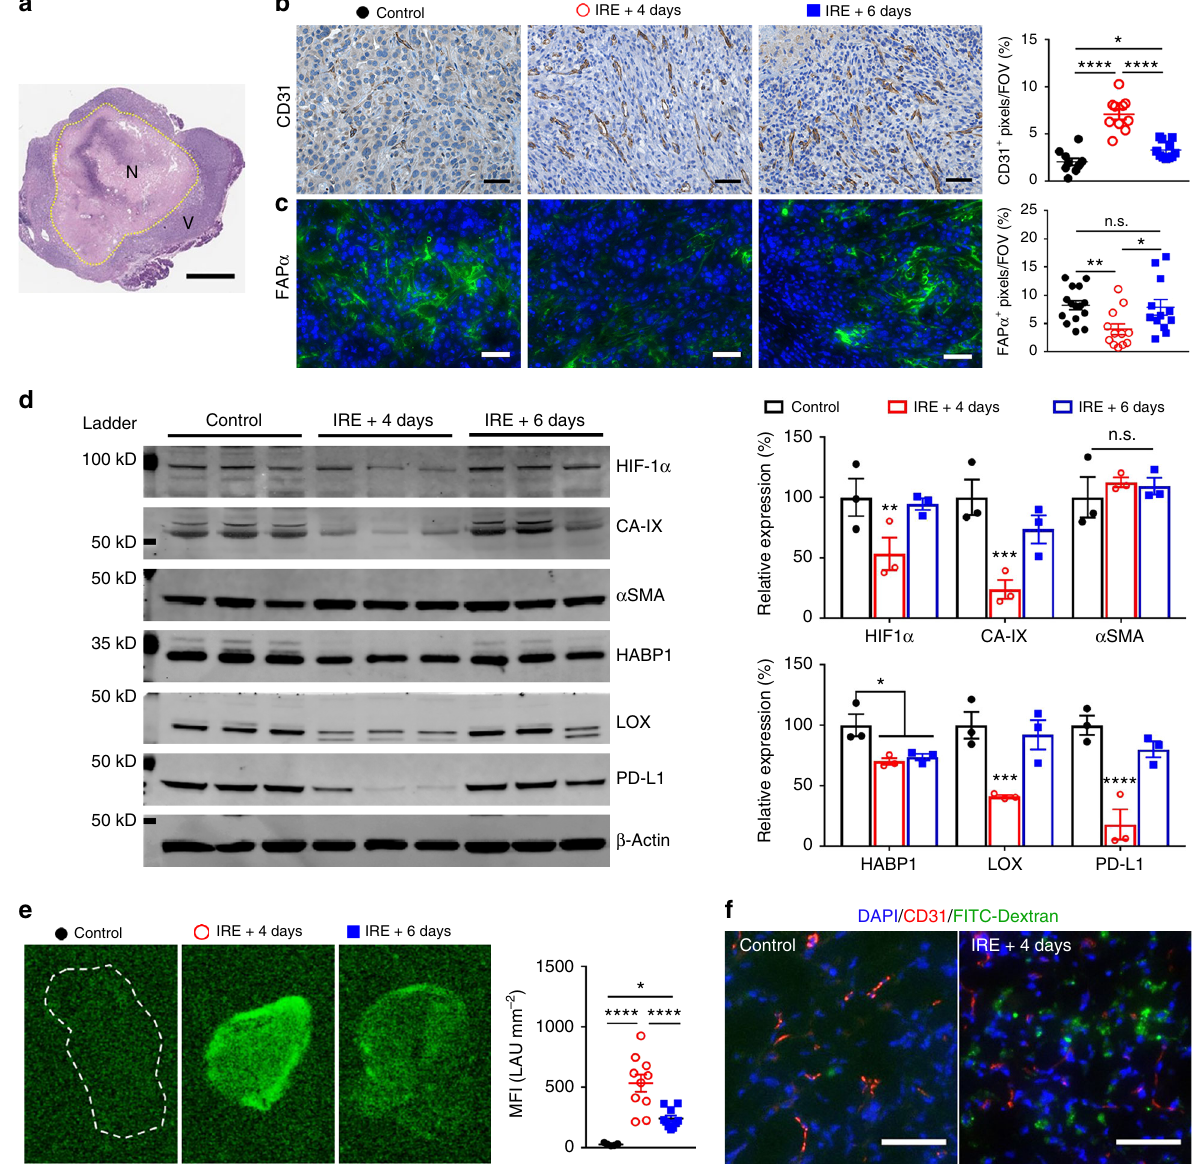
Fig. 6 Impacts of IRE on PDAC stroma. a Representative tumor cross-section after IRE treatment; scale bar = 2 mm. N necrosis, V viable tumor. b , c Representative IHC staining of CD31 and FAP α s in viable tumor regions in the groups of control (black solid circle), IRE + 4 days (red circle), and IRE + 6 days (blue solid square), and corresponding quanti fi cations. Ten to fi fteen 200× fi elds-of-view (FOV) were randomly recorded and analyzed. Scale bar = 50 µ m. d Immunoblotting of tumor lysates ( n = 3 per group) for hypoxia-inducible factor 1 alpha (HIF-1 α ), carbonic anhydrase 9 (CA-IX), α SMA, hyaluronic acid binding protein 1 (HABP1), lysyl oxidase (LOX), PD-L1, and beta-actin ( β -actin). e Representative fl uorescence images of tumor cross-sections and corresponding quanti fi cation of mean fl uorescence intensity (MFI). Five to ten FOVs were randomly imaged in each group and quanti fi ed in terms of MFI. FITC-conjugated dextran (70 kD) was intravenously injected to characterize vascular permeability 24 h before tumors were collected. f Representative dual- fl uorescence images of CD31 (red) and FITC-dextran (green) in tumors. Scale bar = 50 µ m. Data are presented as mean ± SEM. Signi fi cance was determined using 1-way ANOVA followed by Tukey post hoc analysis. * p < 0.05, *** p < 0.001, **** p < 0.0001, n.s. not signi fi cant. Source data are provided as a Source Data fi radiation dose (10 Gy) at the left abdominal region encom- the initial 60-day survival. Therefore, we re-plotted the survival passing pancreas. We limited the radiation dose to 10 Gy curve for the IRE + anti-PD1 treatment group in Fig. 1a up to because of the potential damage to vital organs surrounding 120 days together with that of the 10 Gy + anti-PD1 group pancreas at higher radiation doses in this orthotopic model. In (Fig. 8e). The combined 10 Gy + anti-PD1 treatments resulted comparison, a radiation dose of 20 Gy was used to treat in a similar median survival compared to IRE + anti-PD1 (30 subcutaneous PDAC model in another study 33 . Anti-PD1 was vs. 31.5 days, p = 0.16, log-rank test). However, all mice in the injected at the same schedule as that in the IRE + anti-PD1 10 Gy + anti-PD1 experienced tumor progression, and died by group. We have shown in Fig. 4a that the long-term surviving 55 days after radiation; while 4 out of the 11 IRE + anti-PD1- mice rejected tumor re-challenge for additional 2 months after treated mice survived for 120 days.